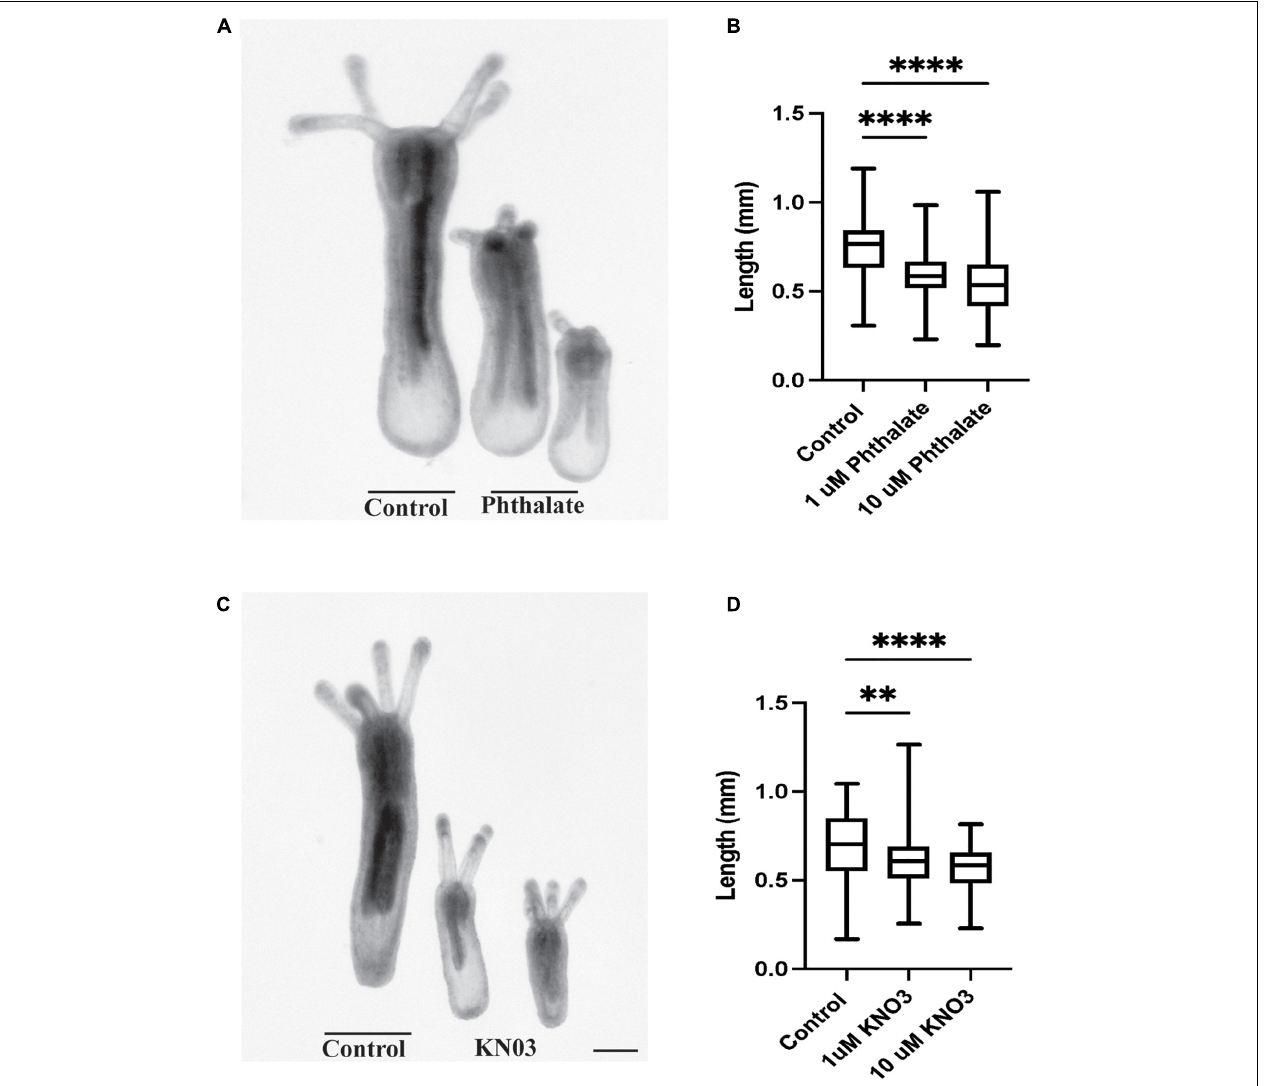
FIGURE 1 | Environmental Stressors Lead to Growth defects in Nematostella embryos. (A) Nematostella embryos exposed to phthalate are significantly shorter when compared to control siblings. (B) Increasing concentration of phthalates does not cause greater defects in overall length of the developing animals (control n = 149, 1 µ M: n = 162, 10 µ M n = 161). (C) Exposure to Potassium nitrate also causes defects in overall embryonic growth in comparison to control. (D) Defects in embryo size do not scale with increasing doses of KNO 3 (control n = 90, 1 µ M: n = 78, 10 µ M n = 65). ∗ p ≤ 0.05, ∗∗ p ≤ 0.01, ∗∗∗ p ≤ 0.001, N.S. is not significant. Scale bar = 100 µ